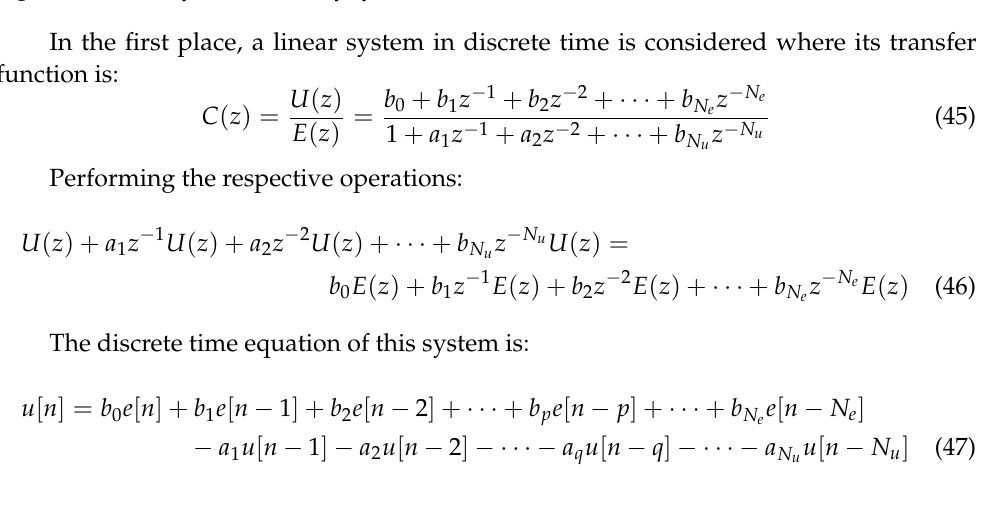
Figure 12. Linear system and fuzzy